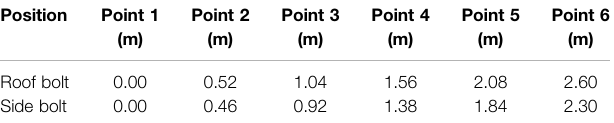
TABLE 2 | Location of measuring